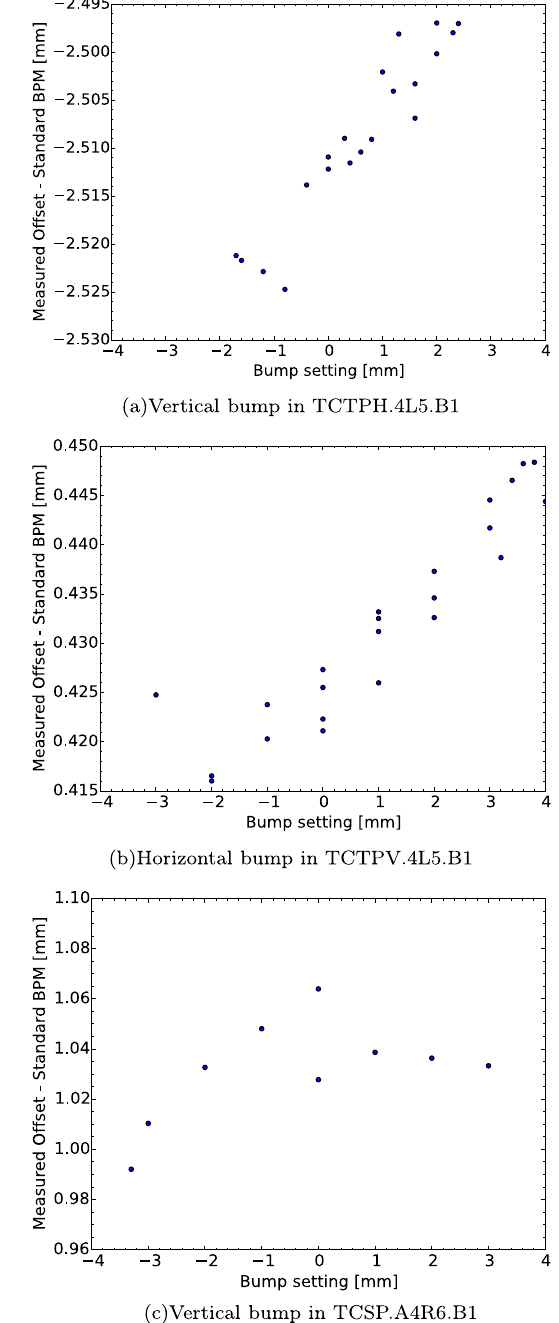
as a function corr